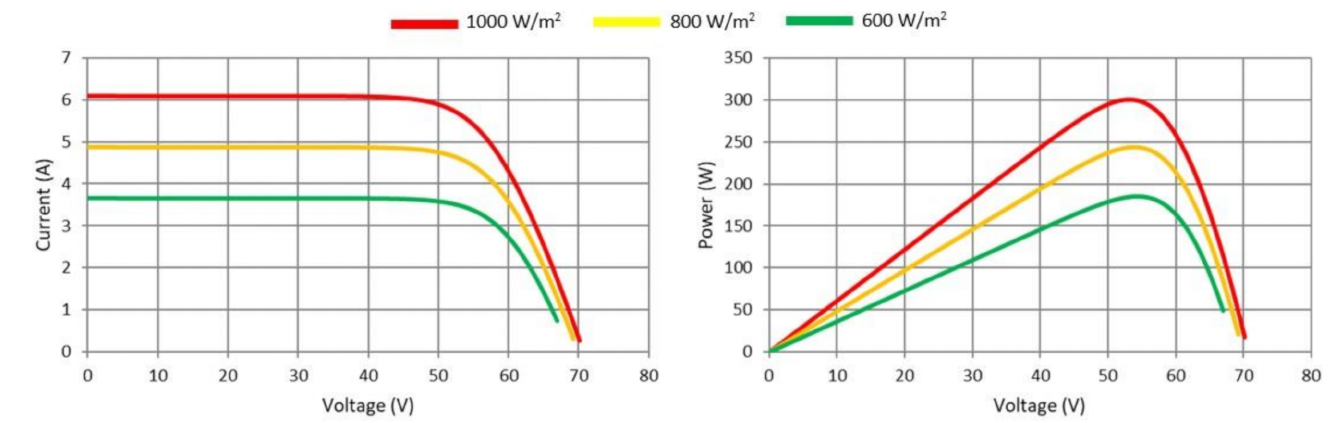
Figure 3. The Current-Voltage and Power-Voltage characteristics of